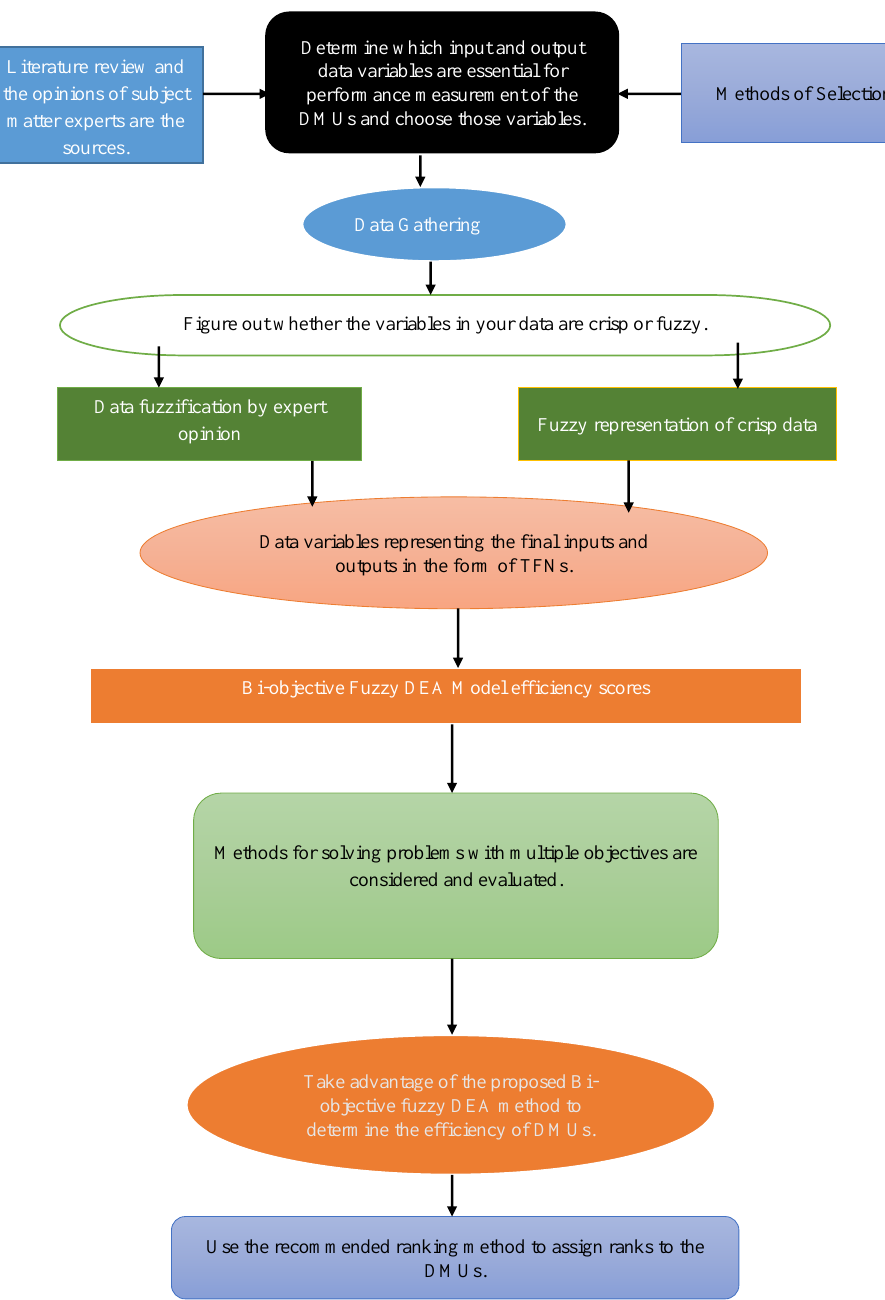
Figure 1. Schematic diagram for efficiency evaluation of